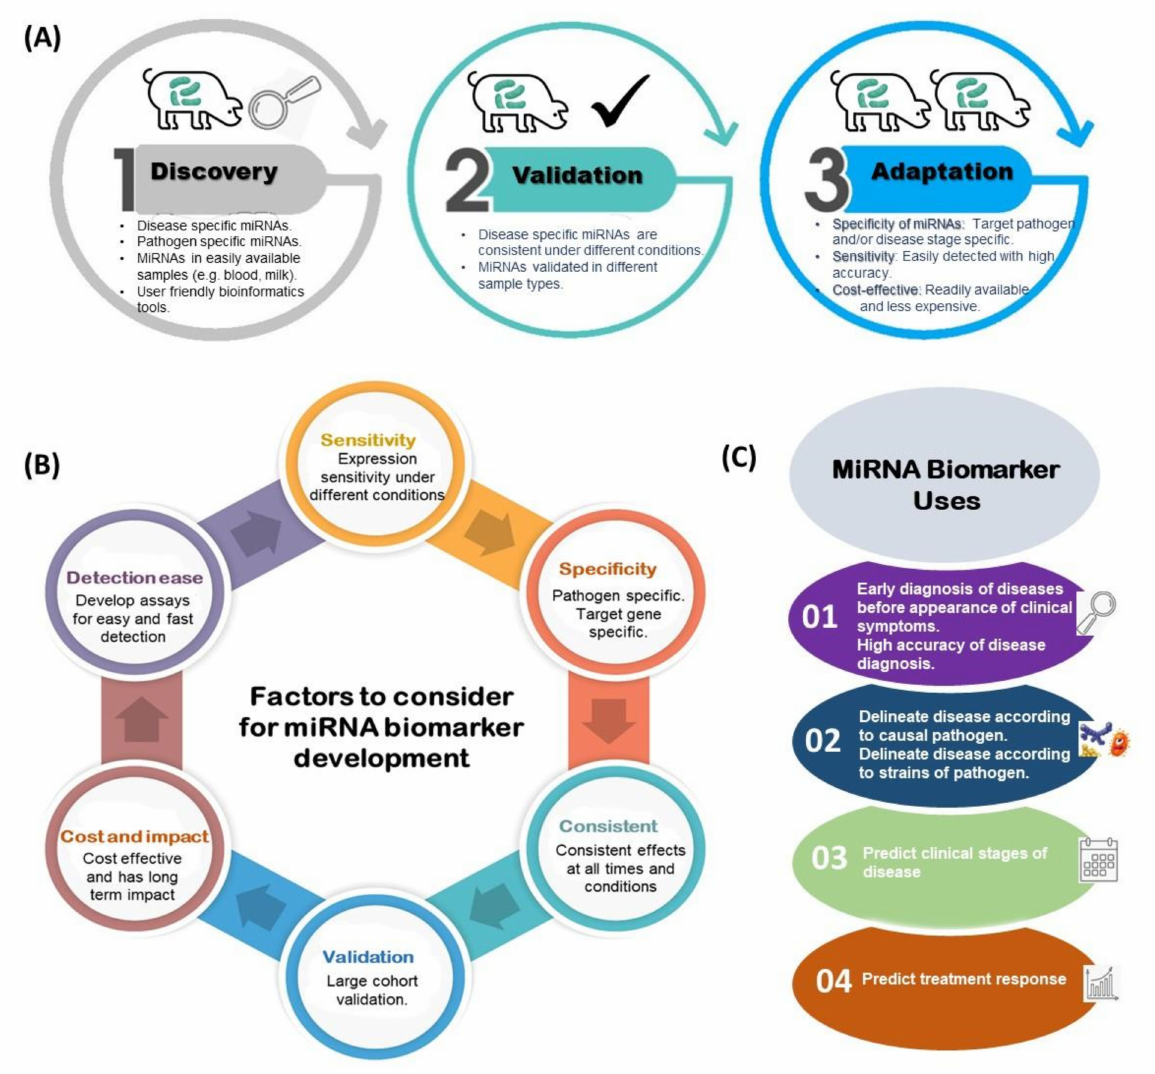
Figure 1. An overview of steps involved in the development of miRNA biomarkers for livestock disease management: ( A ) steps/stages to follow in miRNA biomarker development; ( B ) factors to consider in miRNA biomarker development; ( C ) potential application of miRNA